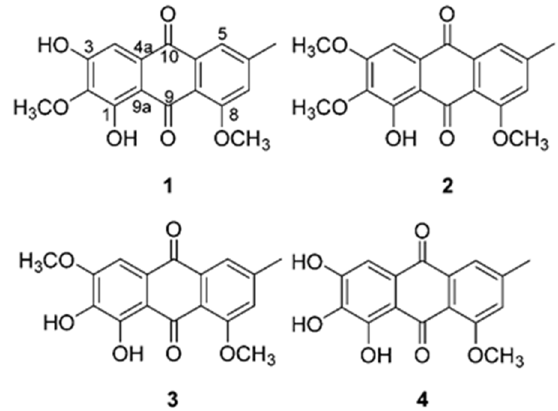
Figure 1. Structure of compounds 1 – 4.